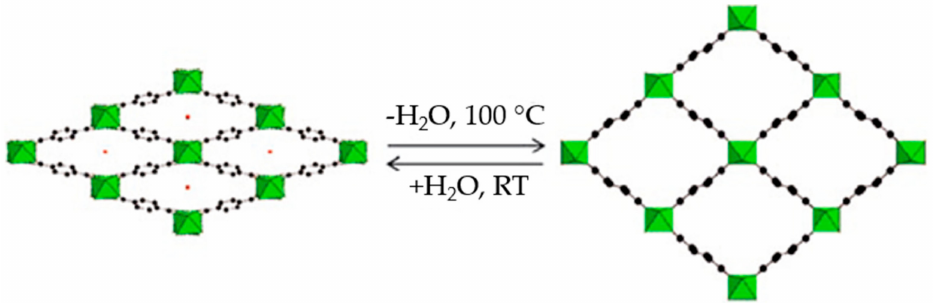
Figure 5. Breathing behavior of MIL-53(Al, Cr) [84].